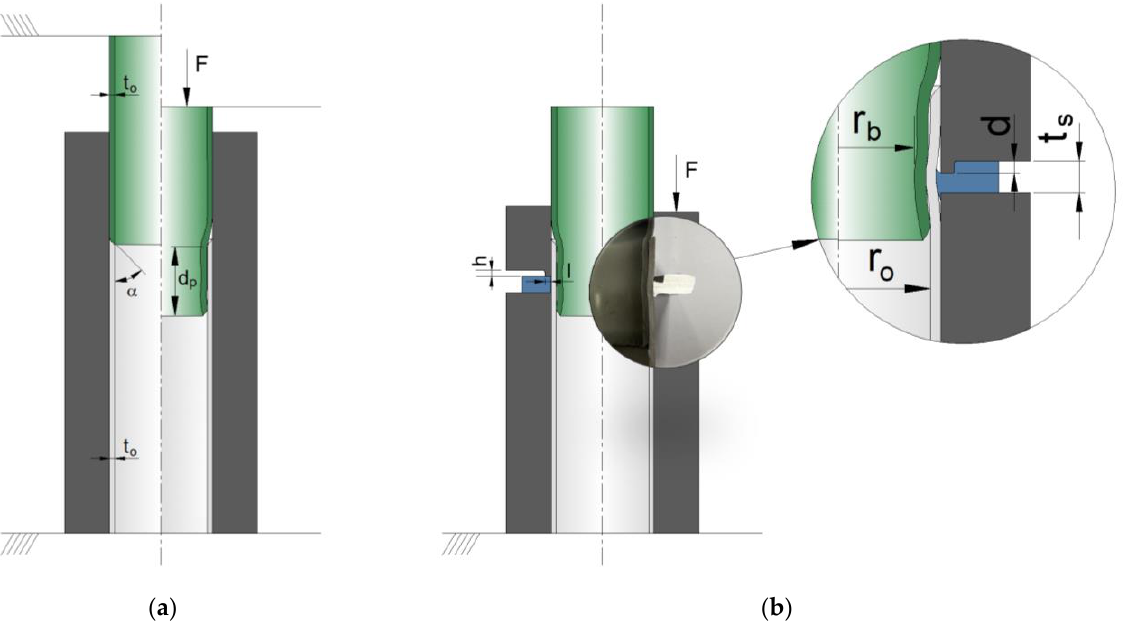
Figure 1. Schematic representation of tube joining by a sheet flange connection: ( a ) PVC tube reduction and ( b ) joining of the PVC and aluminum tubes by indentation and injection of the sheet flange with the correspondent photograph of the joint.